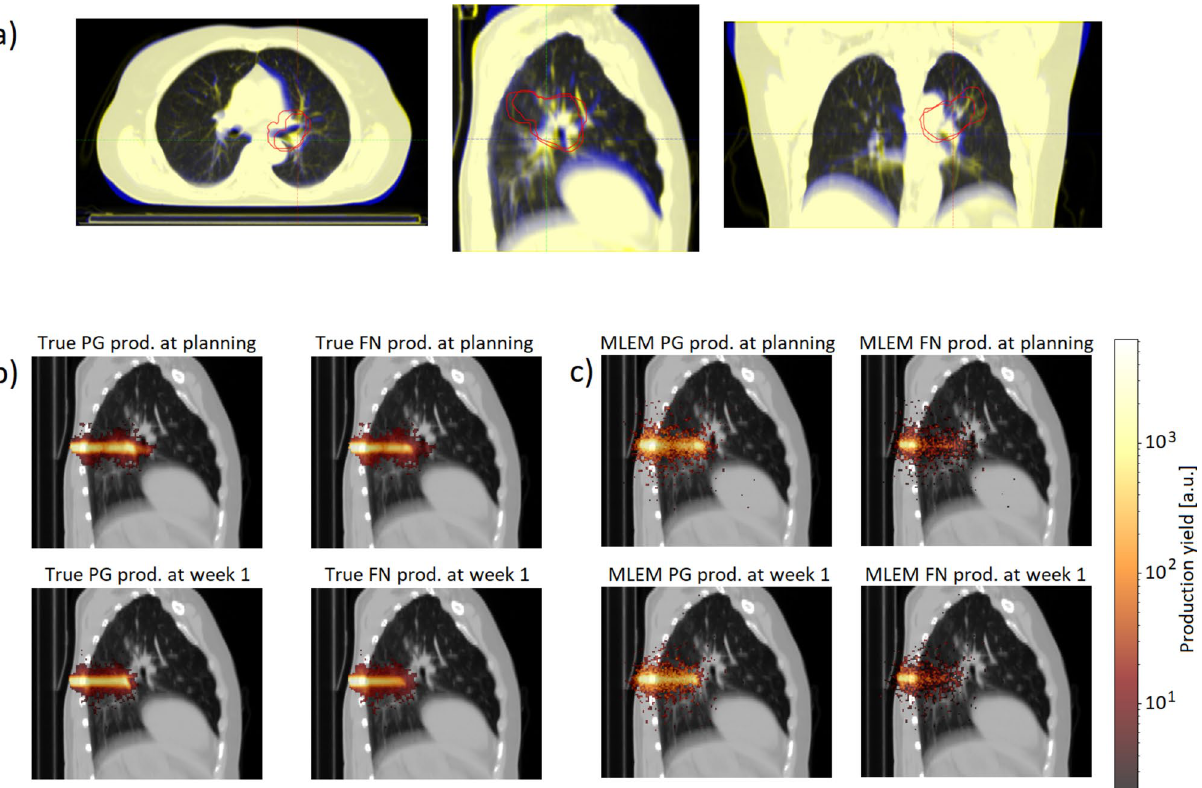
Figure 6. Example of treatment deviation caused by anatomical changes. ( a ) The axial, sagittal and coronal plane of the example patient with the average intensity projection of the 4D planning CT (yellow) overlaid on the repeat CT (blue). The target volume contoured by the treating oncologist on both CTs are visible as red contours. Both a shift and deformation of the target volume with corresponding change in tissue densities can be observed. The lungs are larger on the planning compared to the repeat CT indicating a shallower breathing pattern during acquisition of the latter. ( b ) PG and FN production, both from MC truth and reconstructed with MLEM, from the planning CT (top) and when produced in the week 1 CT, overlaid on the planning CT (bottom).